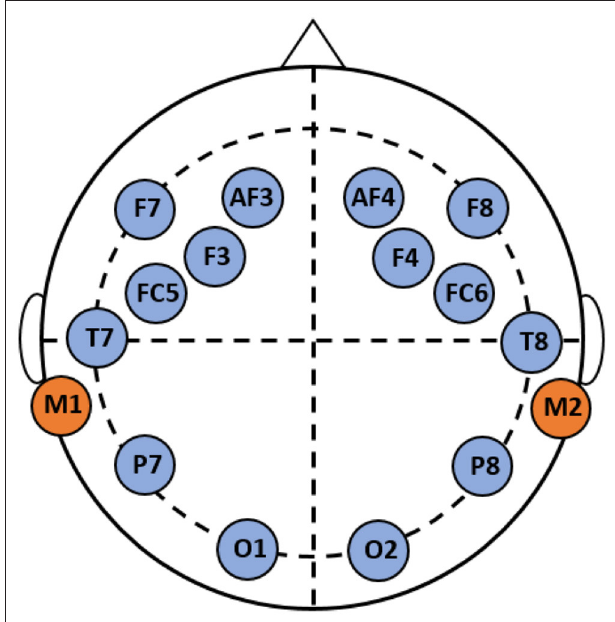
FIGURE 2 | Cortical areas covered by the electrodes of the EEG EMOTIV Epoc.